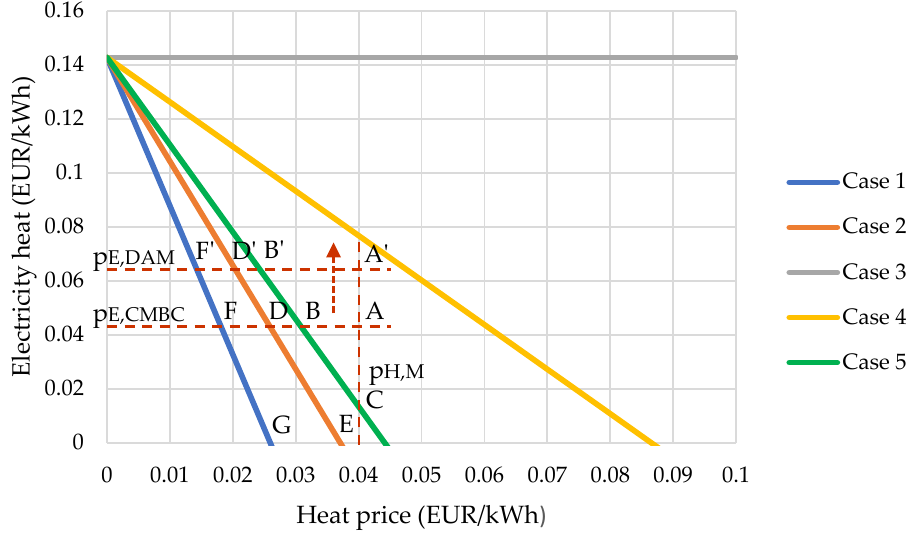
Figure 9. The economic characteristics of the CHP plant operation.